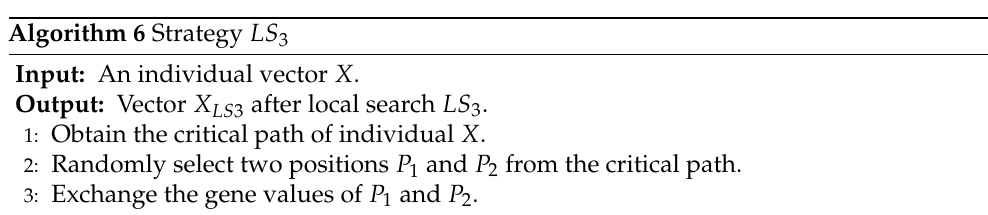
Algorithm 6 Strategy LS